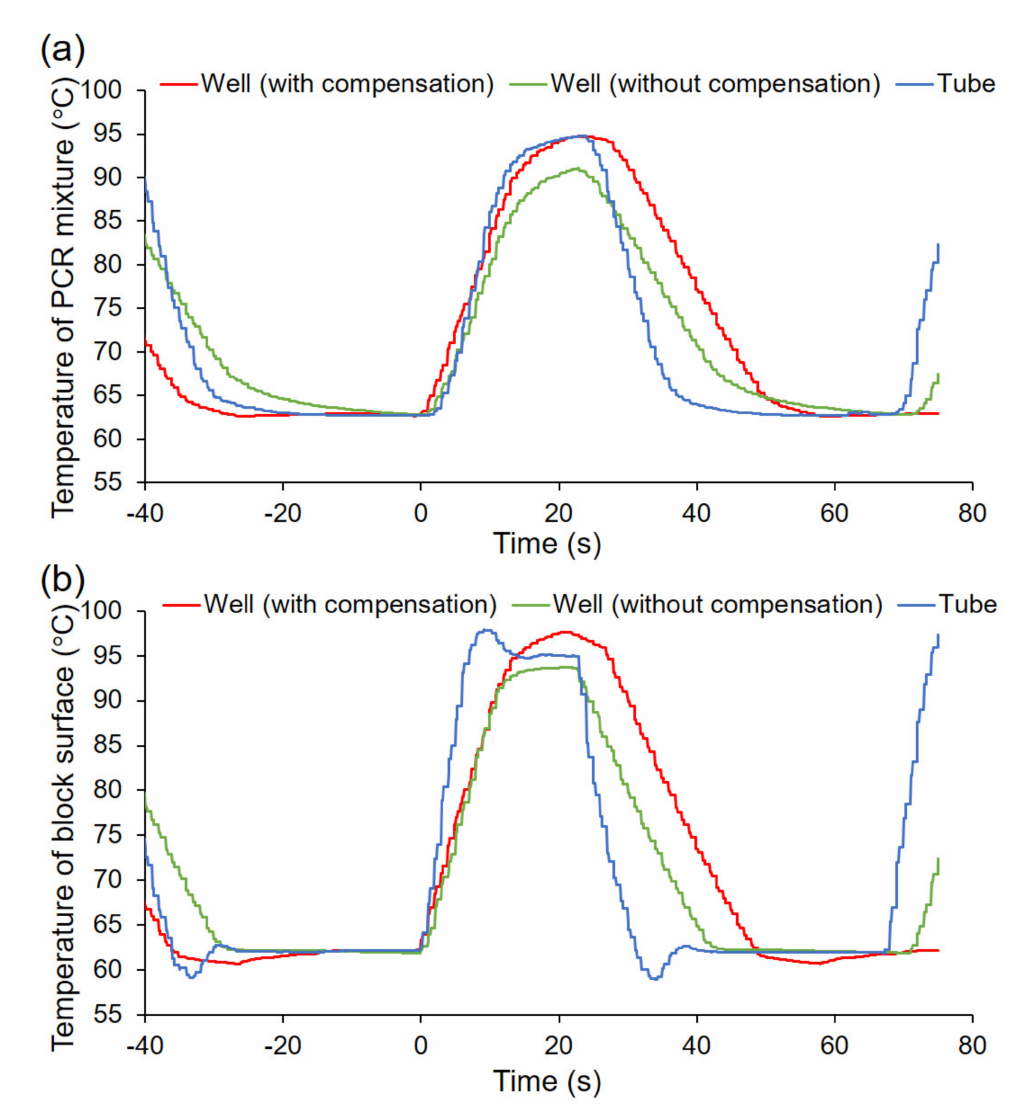
Figure 5. The thermal profiles of the PCR reactions ( a ) in the PCR mixture and ( b ) at the surface of the heating block. The target temperature of the PCR mixture was 95 ◦ C for 10 s for denaturing and 62 ◦ C for 30 s for annealing and extension. The time to start the temperature elevation at the surface of the heating block was defined as 0 s for comparison between the newly developed 384-well plate and a conventional PCR